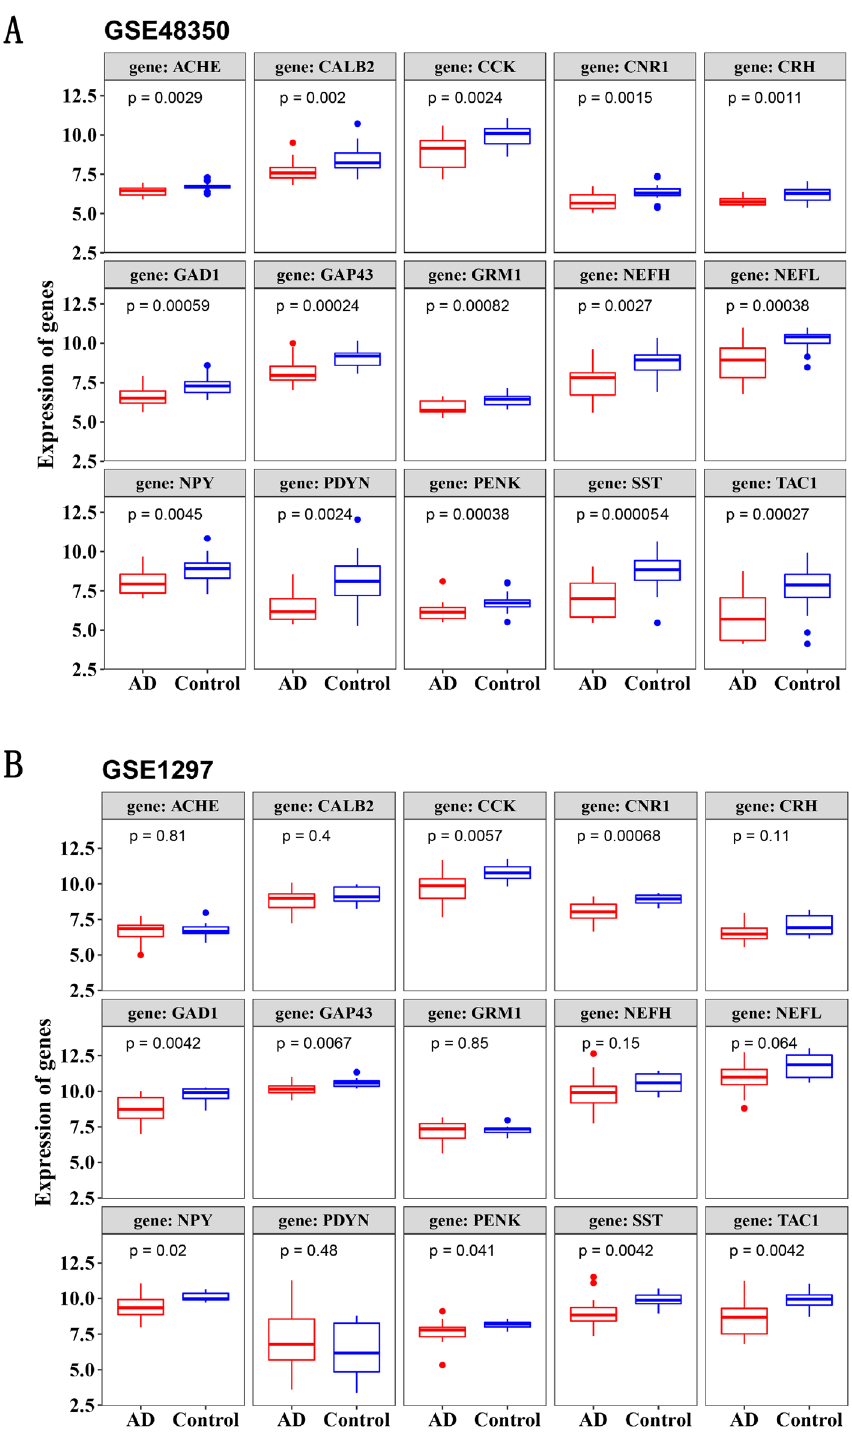
Figure 8. Comparison of diagnostic genes expression between AD and control samples in training dataset GSE48350 ( A ) and external validation dataset GSE1297 ( B ). The 9 diagnostic genes including CCK, CNR1, GAD1, GAP43, NEFL, NPY, PENK, SST, and TAC1 were significantly reduced in AD samples compared with the control